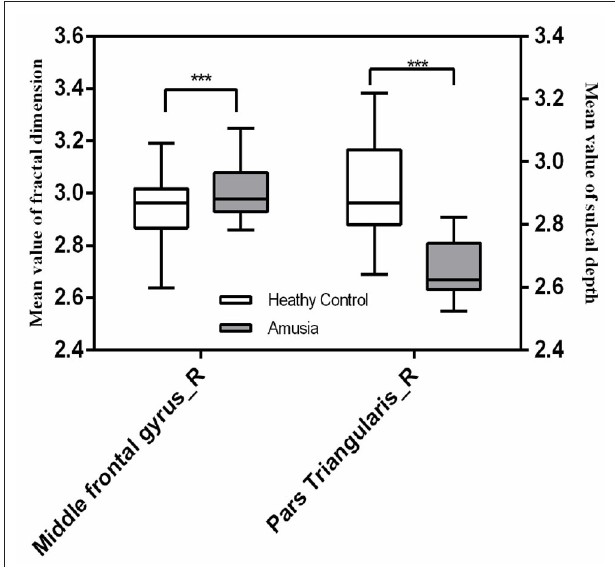
FIGURE 5 | The mean fractal dimension value in the right caudal middle frontal gyrus and sulcal depth in the right pars triangularis in the two groups. The right caudal middle frontal gyrus exhibited a significant increase in the mean fractal dimension value in the congenital amusia group, and the right pars triangularis gyrus showed a significant decrease in the mean fractal dimension value in the congenital amusia group. *** p <